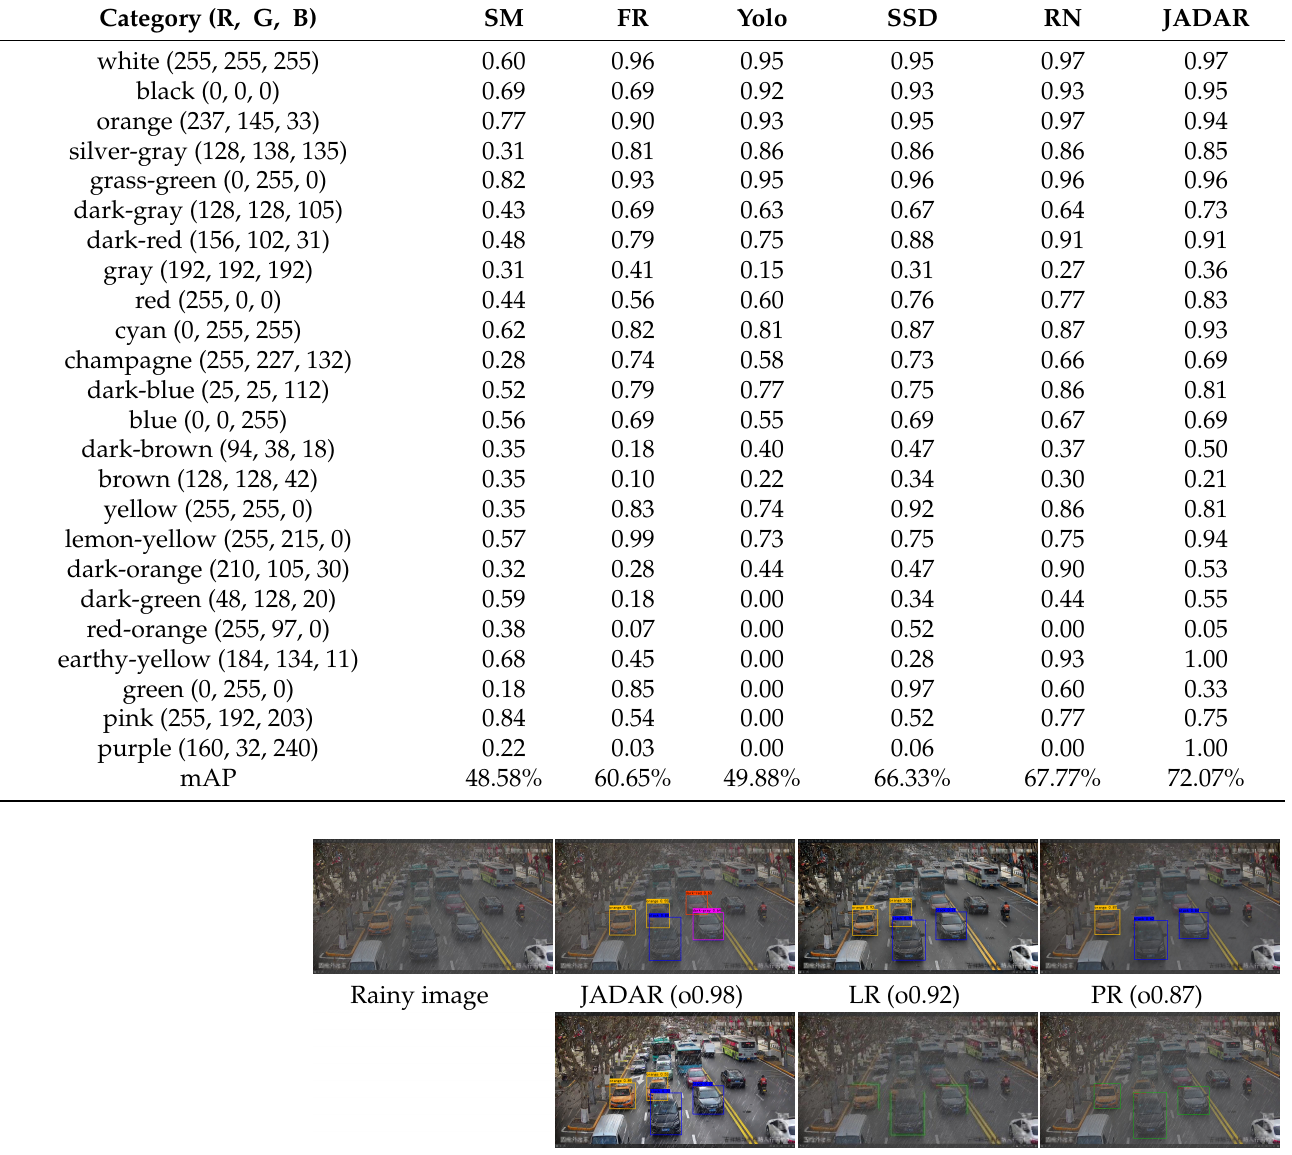
Table 2. Comparison of recognition accuracy of 24 colors for different network classifications: SM,